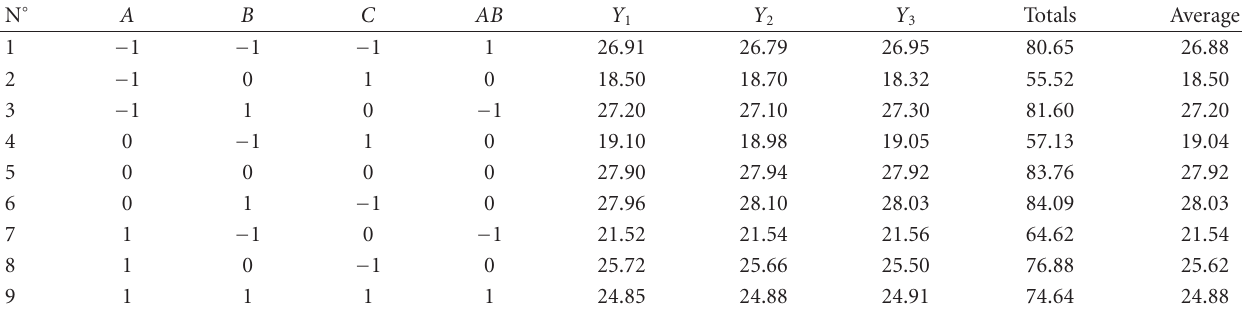
Table 8: Experiment plan (3 3